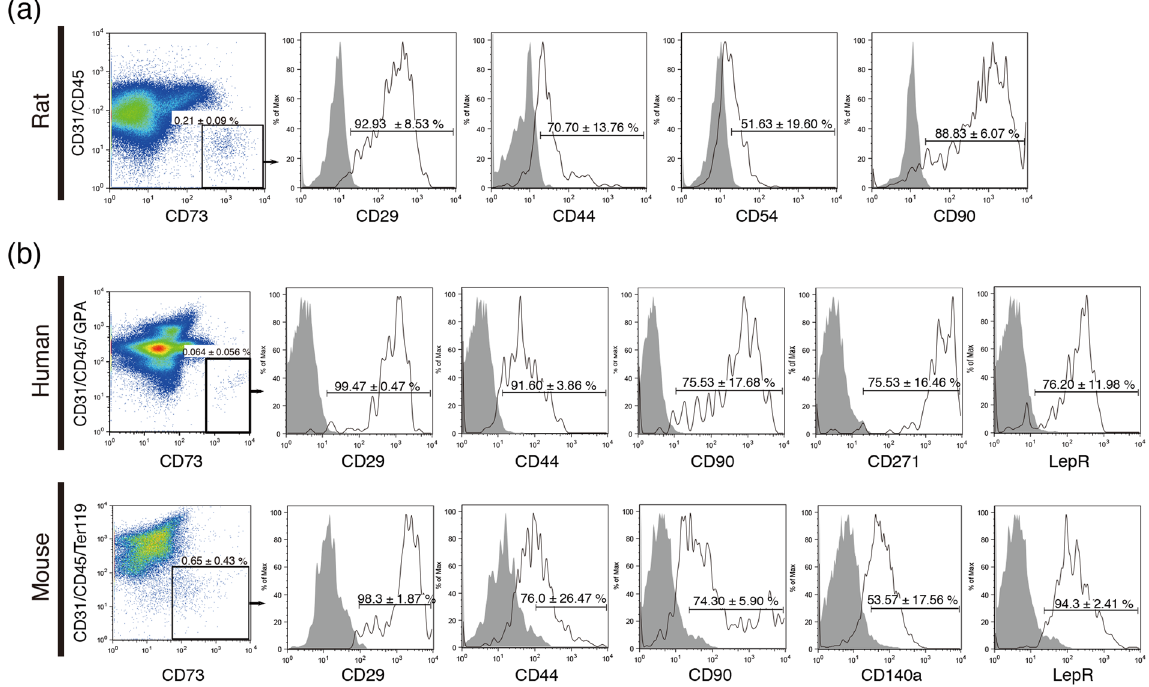
Figure 5. CD73 is commonly available for the prospective isolation of MSCs. ( a ) Representative results of flow cytometric analysis for cell surface markers using freshly isolated BMMNCs from rats. The CD73 + population is positive for previously described MSC markers (CD29, CD44, CD54, and CD90). ( b ) Flow cytometric analysis in the CD73 + population for cell surface markers from human and mouse BM (CD29, CD44, CD90, CD140a, CD271, and leptin